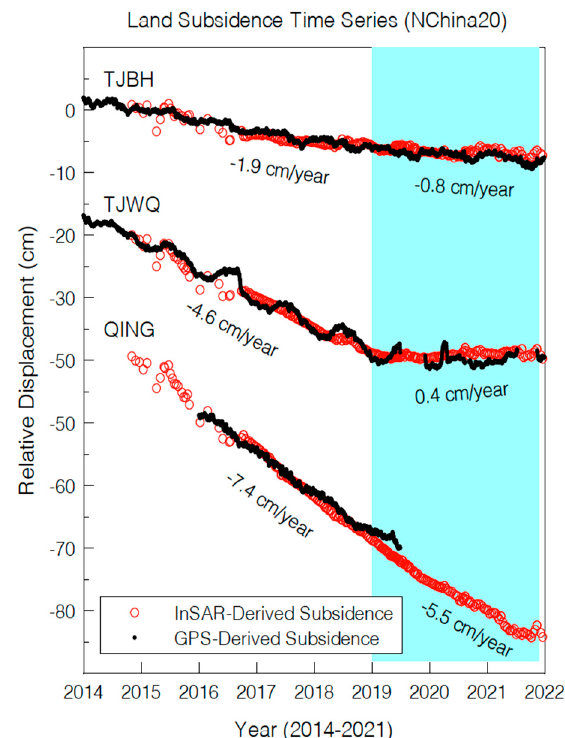
Figure 8. Comparisons of InSAR-derived and GPS-derived subsidence time series at three GPS sites, i.e., TJBH, TJWQ, and QING. The locations of these sites are marked in Figure 1. The GPS-derived time series are smoothed with a 6-day moving